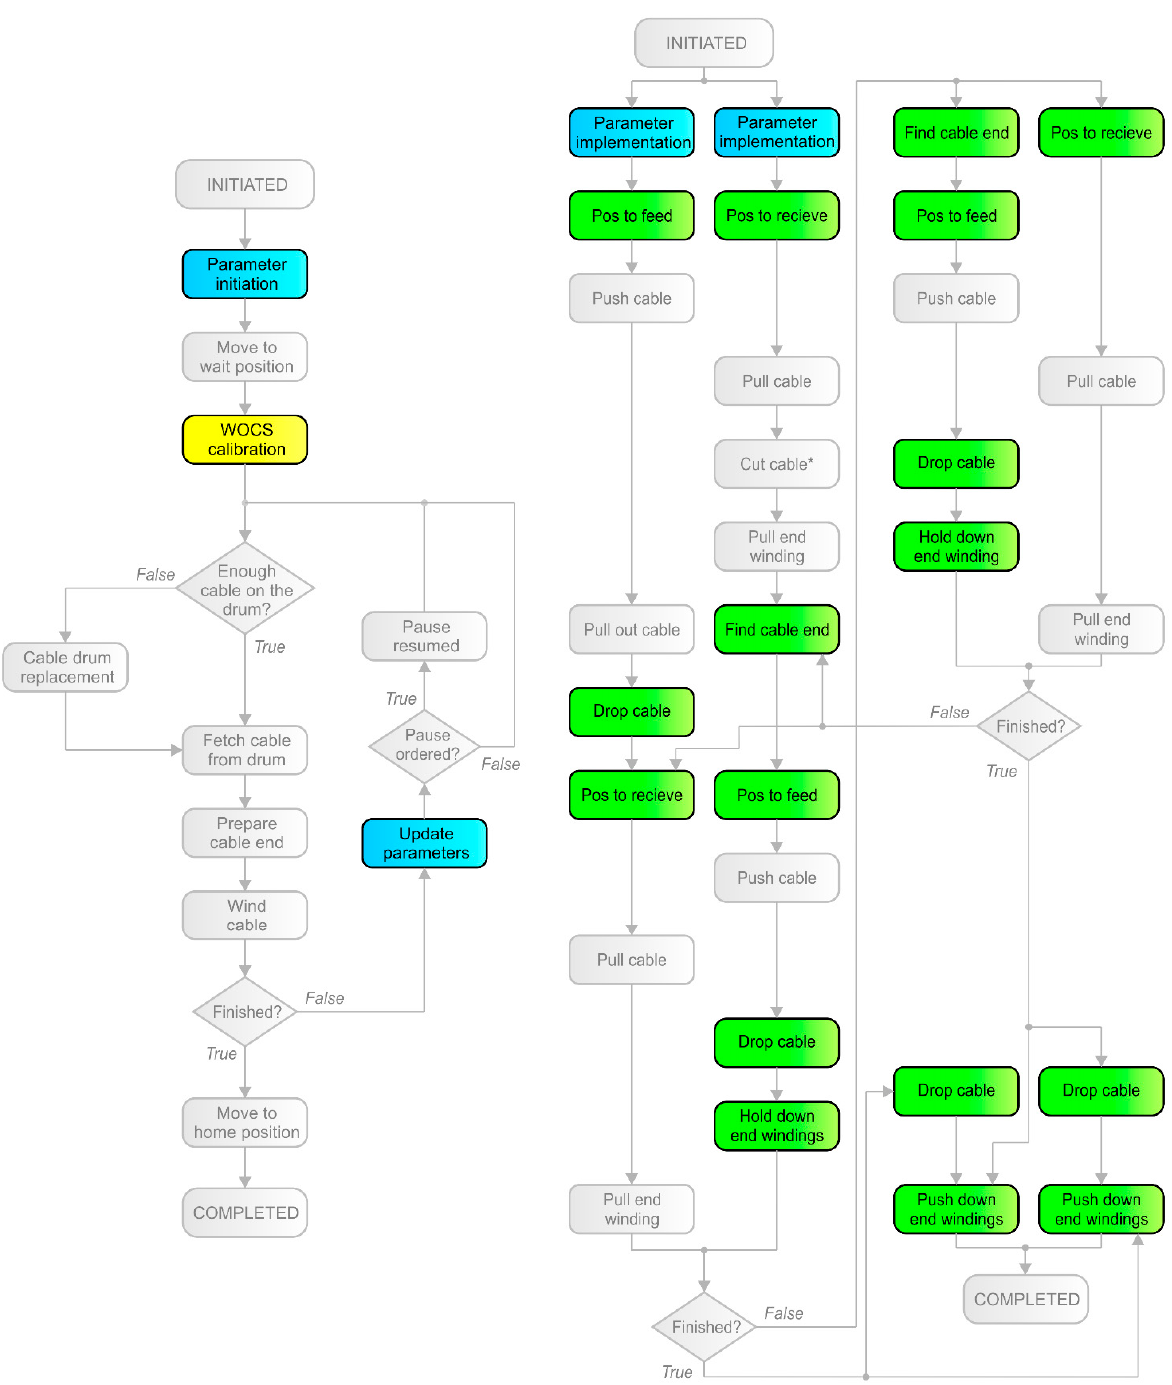
Figure 4. Detailed illustrations of the PLC ( left ) and robot controller ( right ) processes for robotized stator cable winding, with the sub-procedures most critical to adjust to adapt to rotating machines highlighted. Original figures are from